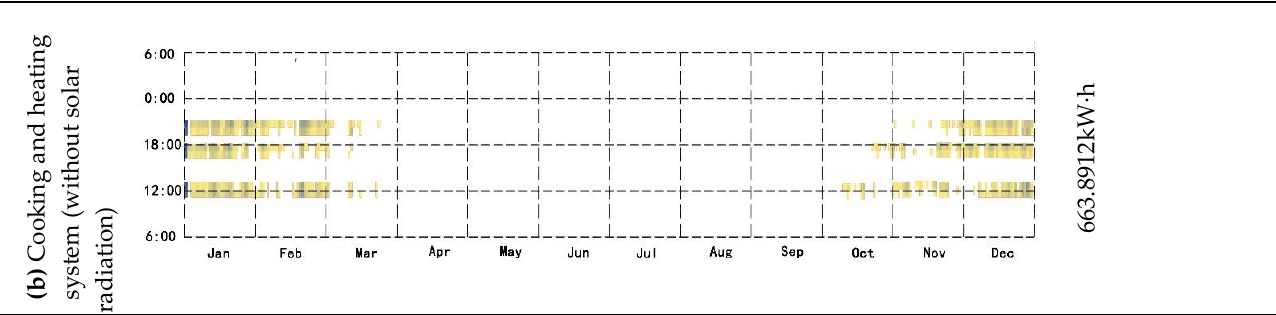
Figure 14. ( a ) The annual average load reduction in the cooking and heating system with solar radiation; ( b ) The annual average load reduction in the cooking and heating system without solar radiation.